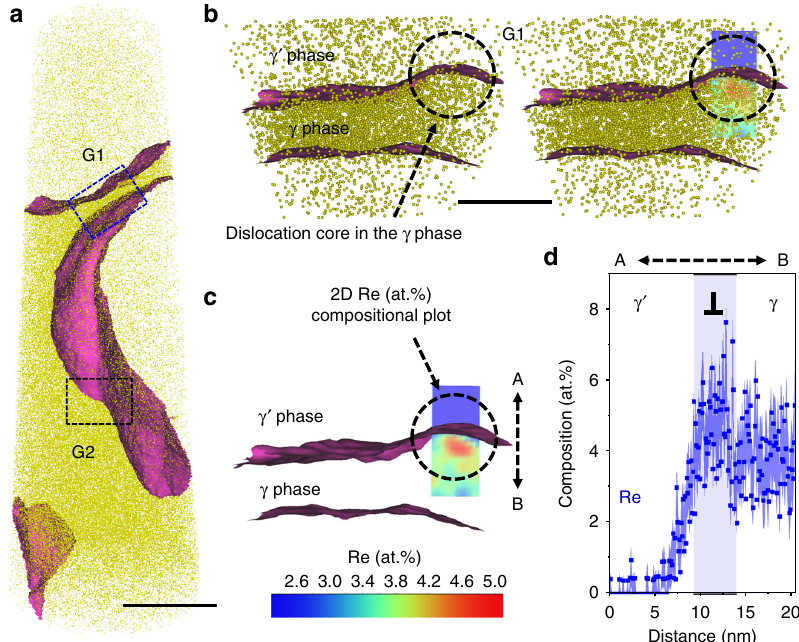
Fig. 5 APT analysis of γ / γ ′ interfacial dislocations for 5% crept sample. a APT reconstruction showing γ / γ ′ interfaces and the two groove regions G1 and G2. b Enlarged view of groove region G1 (blue dashed rectangle) with distribution of Co atoms. c A 2D Re at% compositional pro fi le across G1 reveals higher Re concentration at G1 indicating Re enrichment at interfacial dislocations. d 1D compositional pro fi le of Re across G1 (along AB). Scale bar: a 50 nm. b 20 nm. The detailed analysis of groove G2 is shown in Supplementary Fig. 5. The error bars in ( d ) are estimated as described in Methods